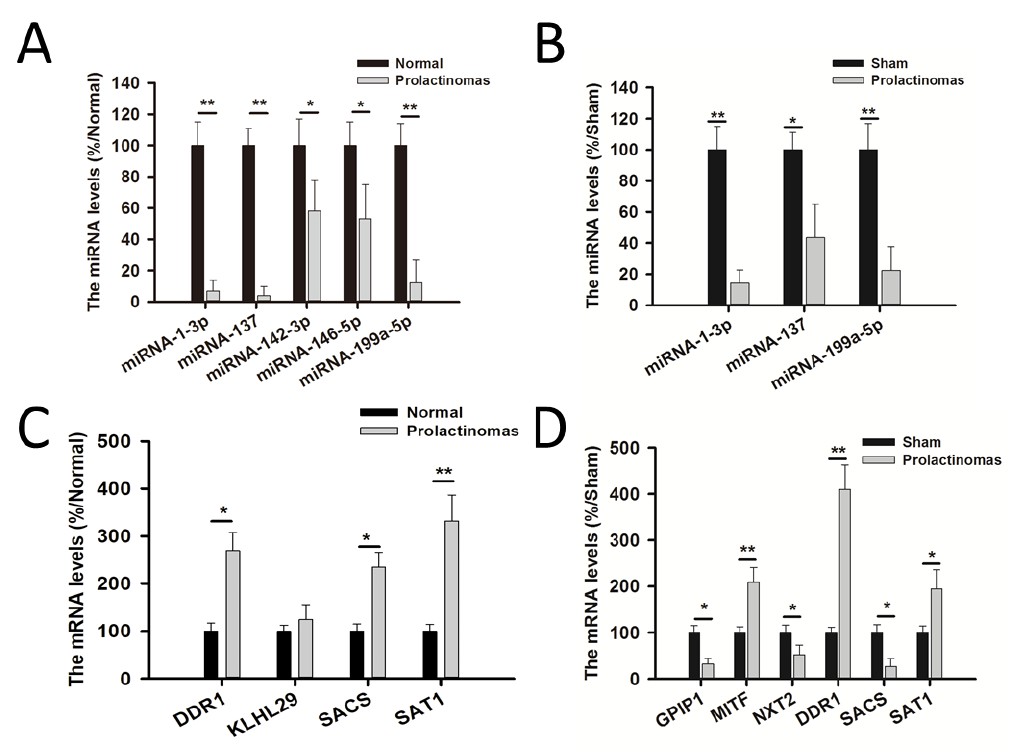
Figure 2: A novel miRNA–gene network regulating prolactinoma formation in patients and animals. RT-qPCR analysis of five miRNAs and 12 target genes confirmed changes in mRNA levels. A: Five miRNAs from prolactinoma specimens. B: Similar changes in miRNA-1-3p, miRNA- 137 and miRNA-199a-5p in the animal model. C: mRNA levels of miRNA-199a-5p target genes in prolactinomas. D: mRNA levels of miRNA- 199a-5p target genes in the animal